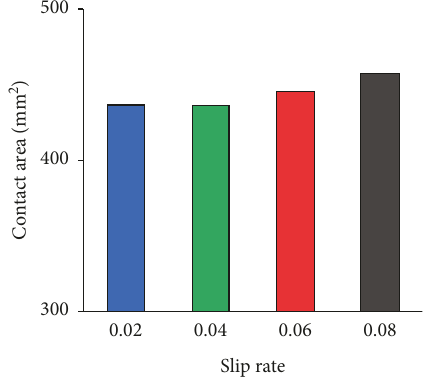
Figure 14: Contact area under different slip